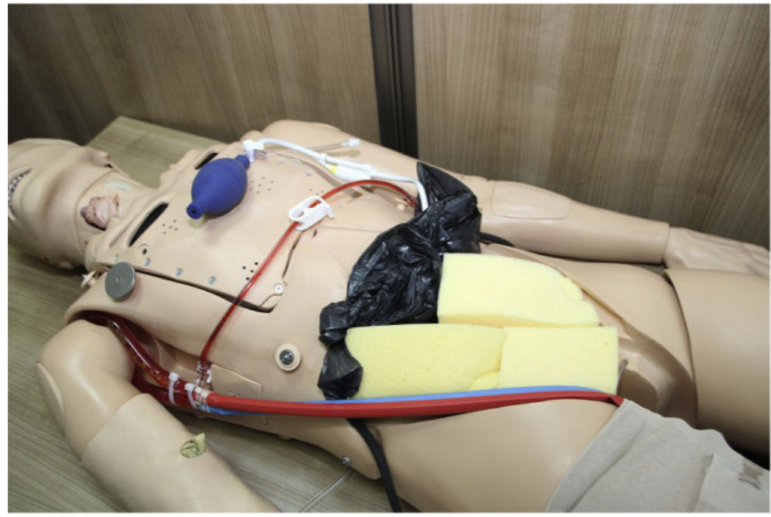
Figure 16. Adult ECMO simulator demo